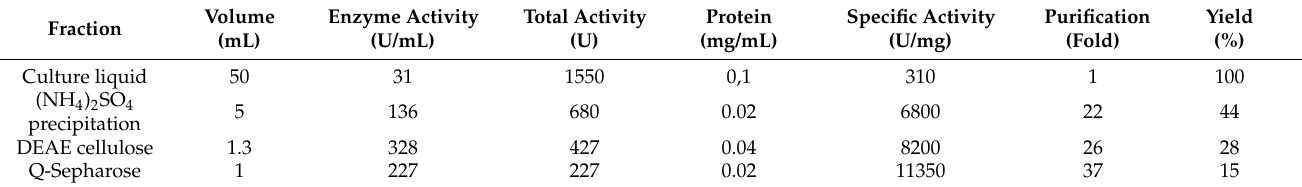
Table 1. Summary of the purification of the extracellular sialidase from O. paurometabola